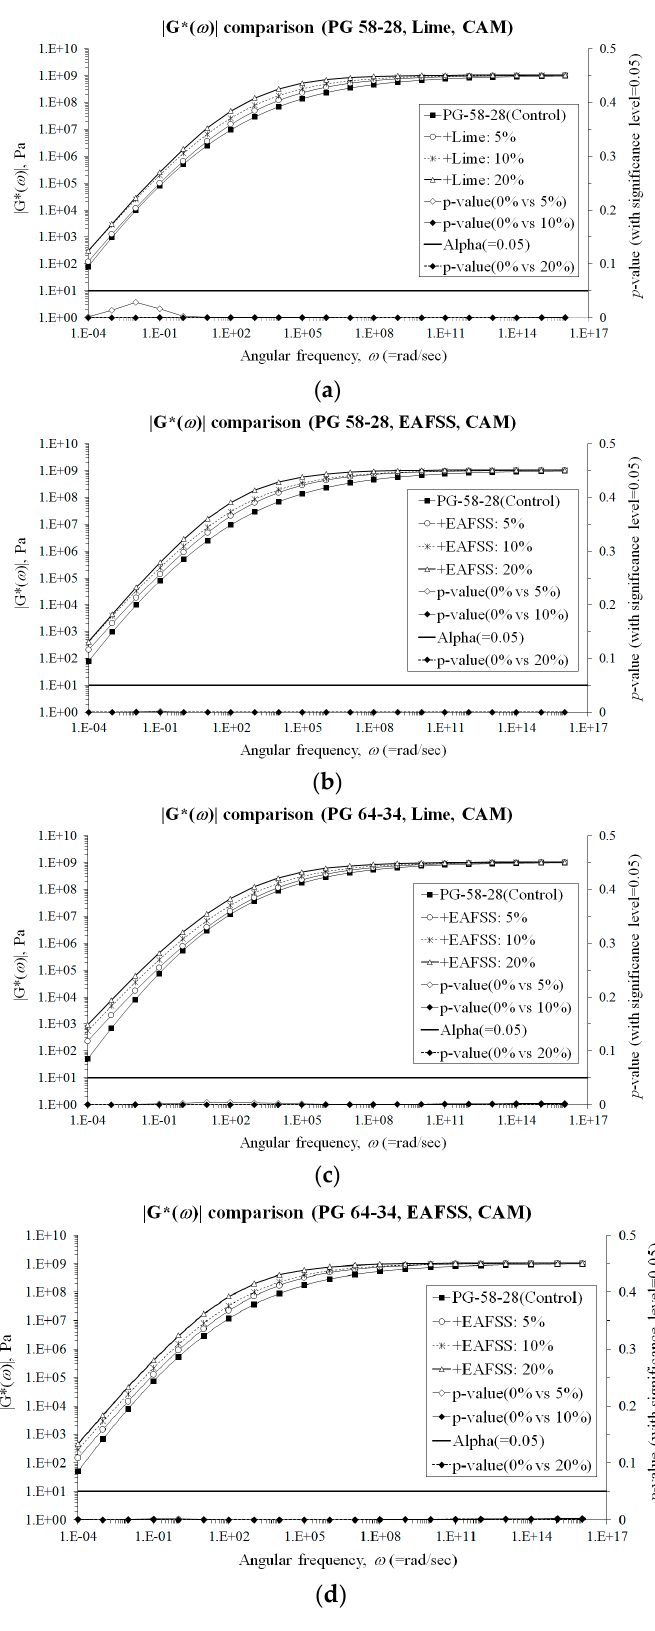
Figure 9. | G* ( ω )| comparisons by using the CAM model [35]. ( a ) | G* ( ω )| comparisons (PG 58-28, Lime, CAM); ( b ) | G* ( ω )| comparisons (PG 58-28, EAFSS, CAM); ( c ) | G* ( ω )| comparisons (PG 64-34, Lime, CAM); ( d ) | G* ( ω )| comparisons (PG 64-34, EAFSS, CAM).